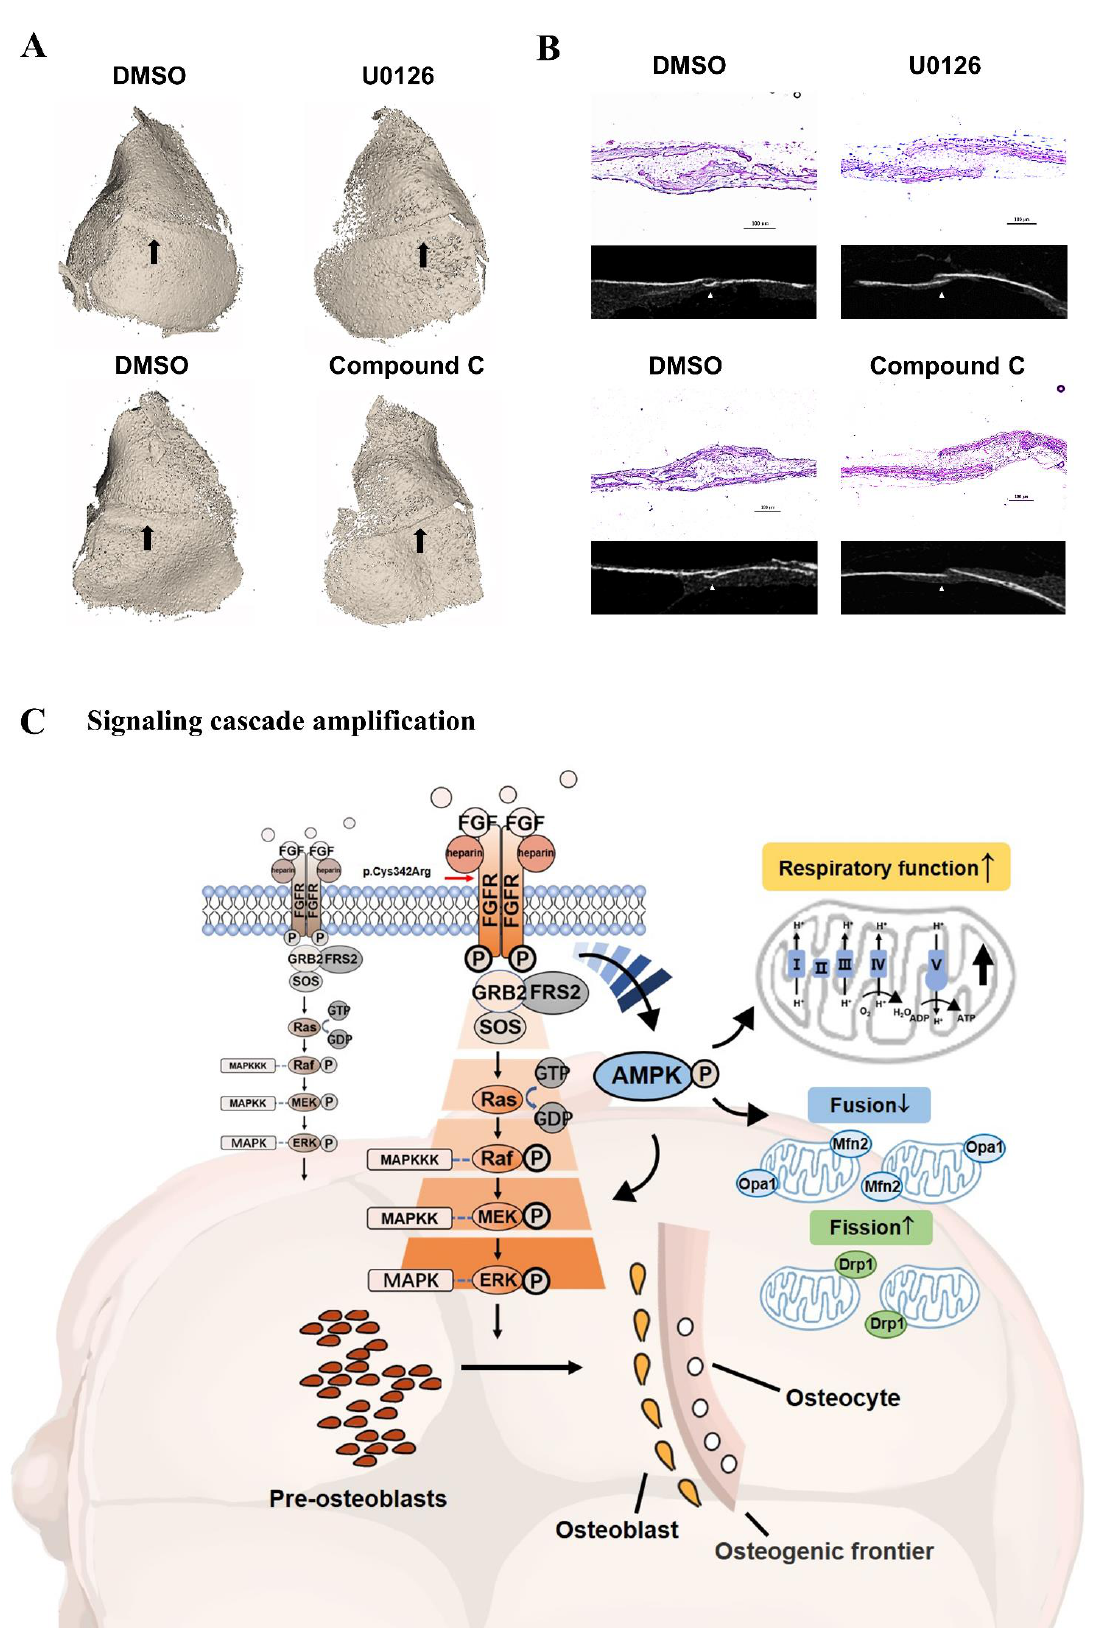
Figure 8. ( A ) U0126 and Compound C attenuated the closure of coronal sutures of cultured calvarias. It was shown by 3D reconstruction images that there was an obvious linear gap between the